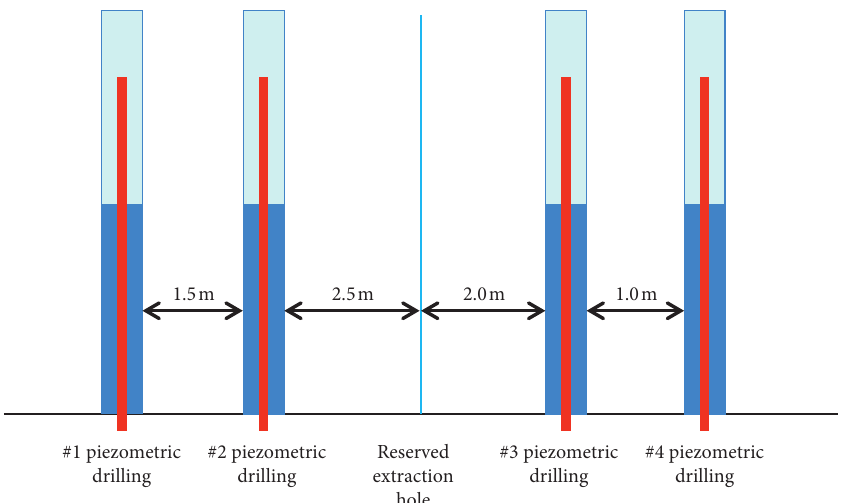
Figure 5: Layout of the pressure-measuring borehole.